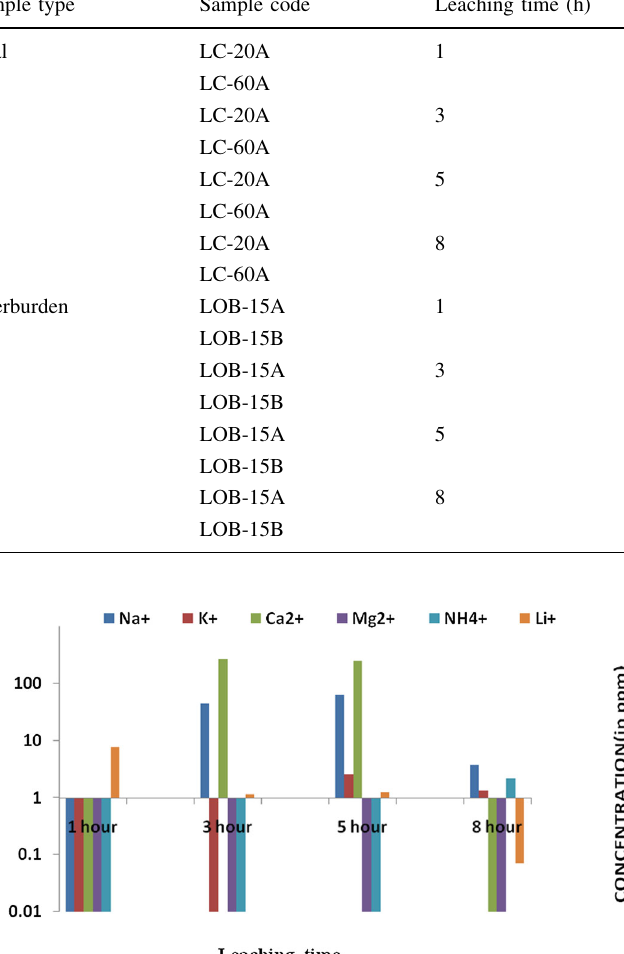
Table 1 Physical analysis of aqueous leachates at room temperature at different leaching times Sample type